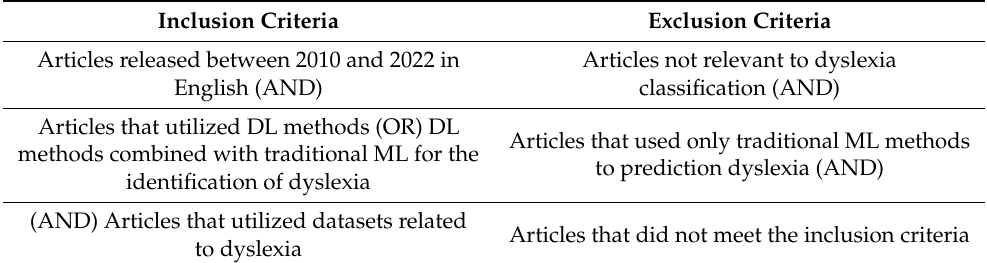
Table 1. Inclusion and exclusion criteria.